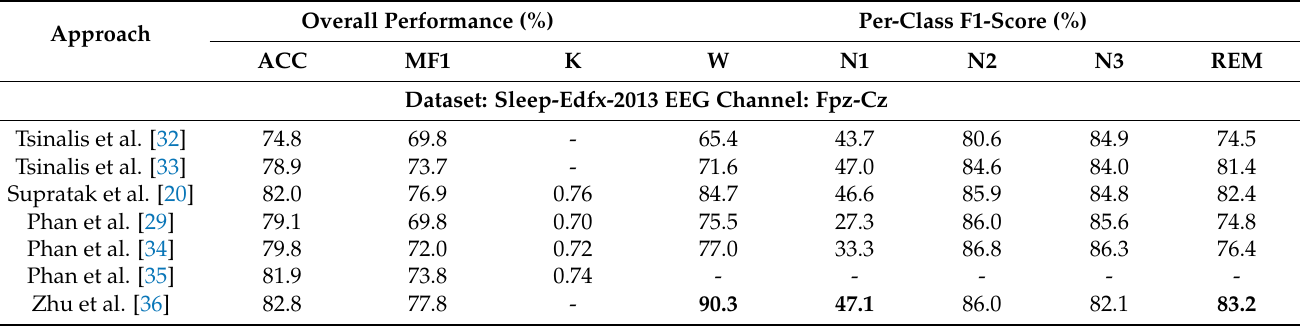
Table 4. Comparison among CAttSleepNet and other